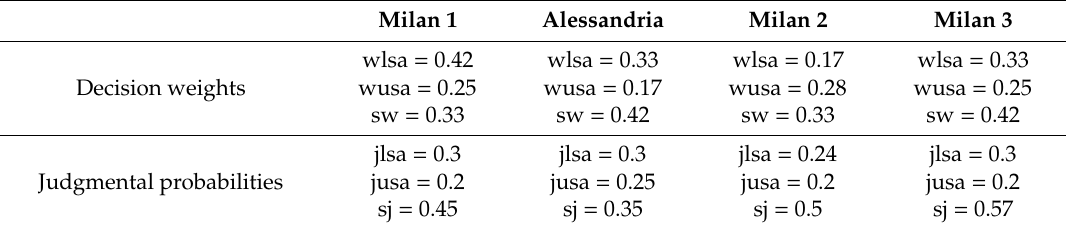
Table 3. Lower subadditivity (LSA) and upper subadditivity (USA): Median values across subjects. Milan 1